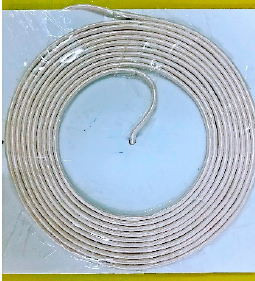
Figure 10. Receiving coil. Table 5. Experiment related parameters.